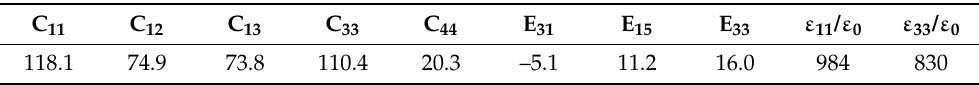
Table 1. PZ27 real